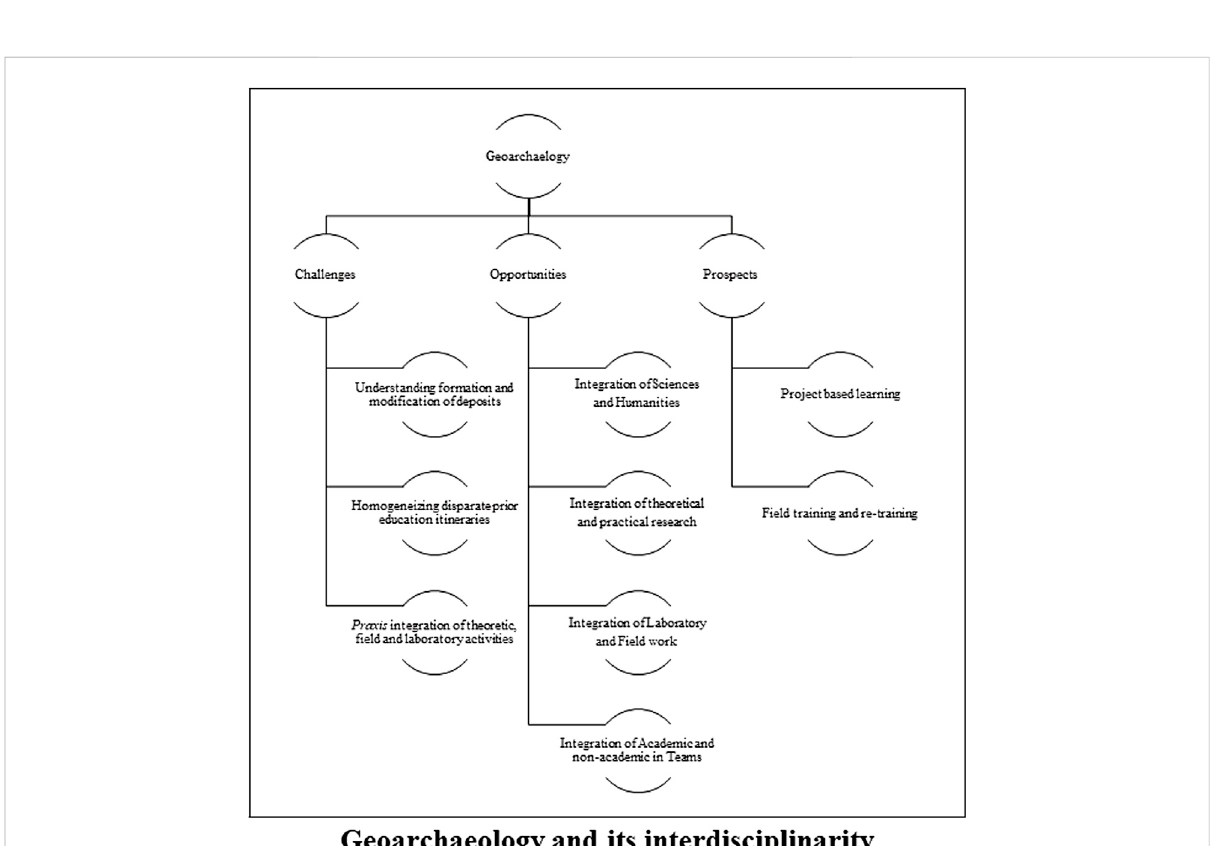
FIGURE 2 Challenges, opportunities, and prospects in